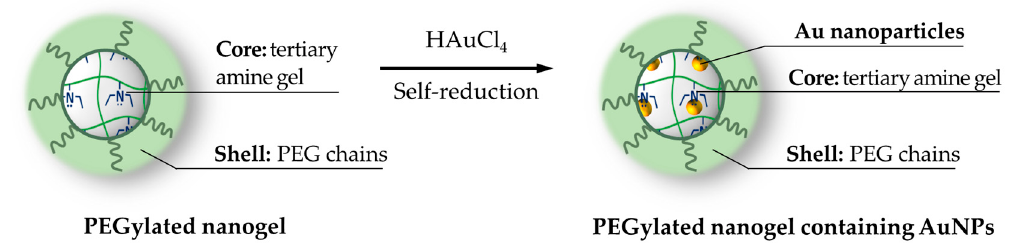
Figure 2. Structure of hybrid PEGylated nanogel prepared by in situ self-reduction of HAuCl 4.